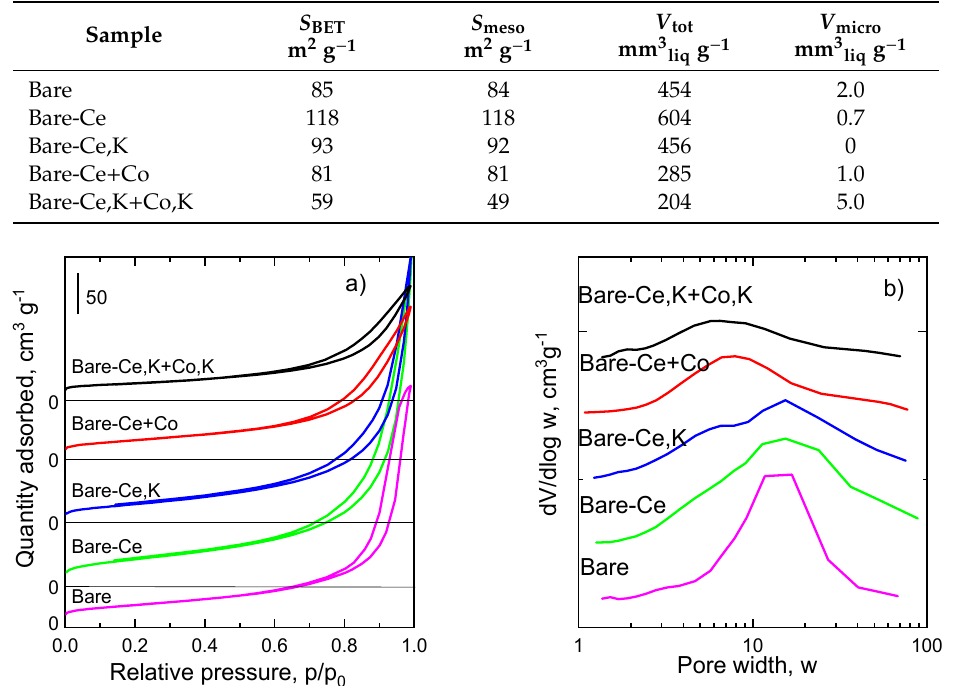
Table 2. Characteristic values of catalysts’ pore size distributions.